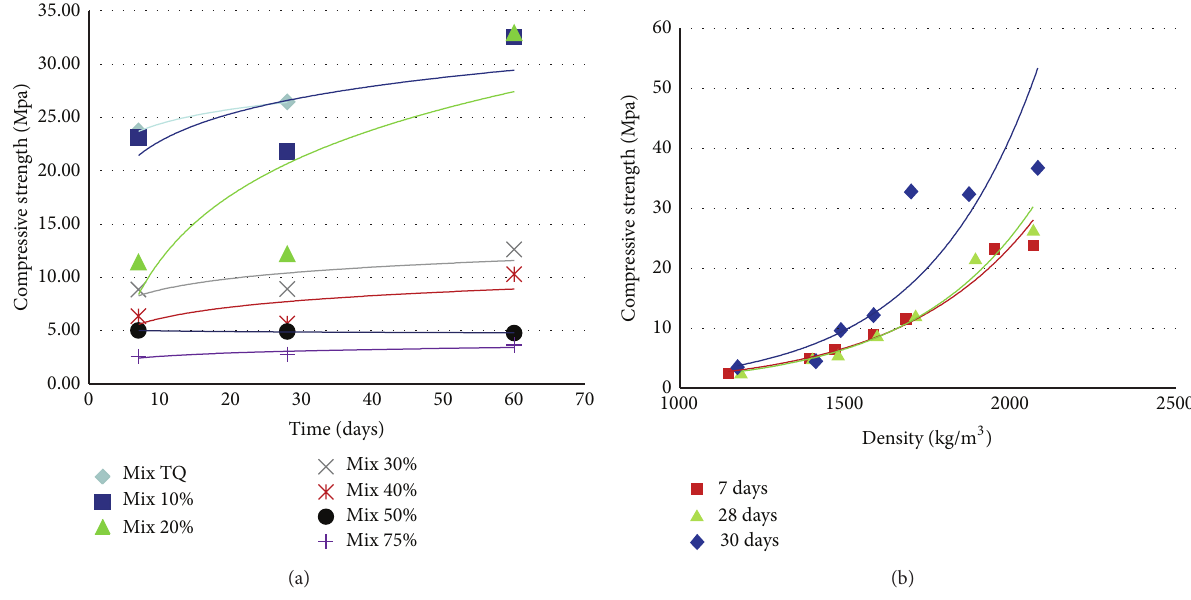
Figure 7: Compressive strength of rubber cement composites against (a) curing time; (b)